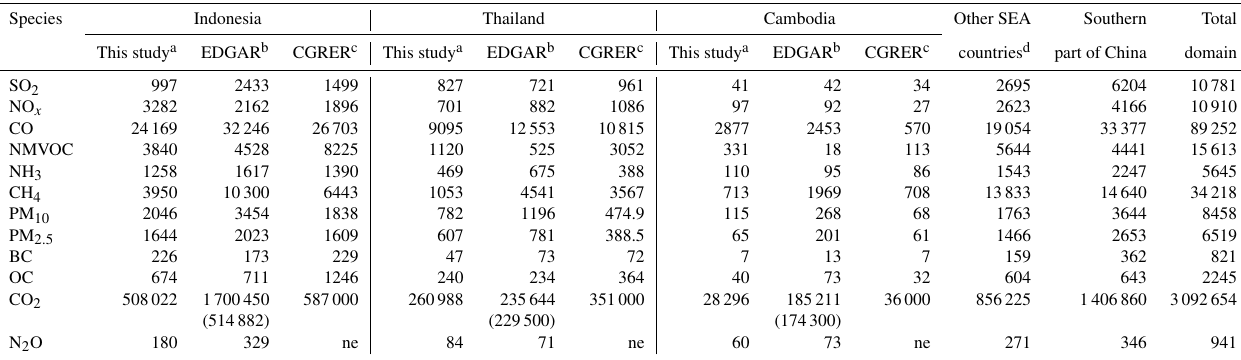
Table 2. EI results for base year in comparison with the existing regional EI datasets (Ggyr − 1 ). Species Indonesia Thailand Cambodia Other SEA Southern Total This study a EDGAR b CGRER c domain SO